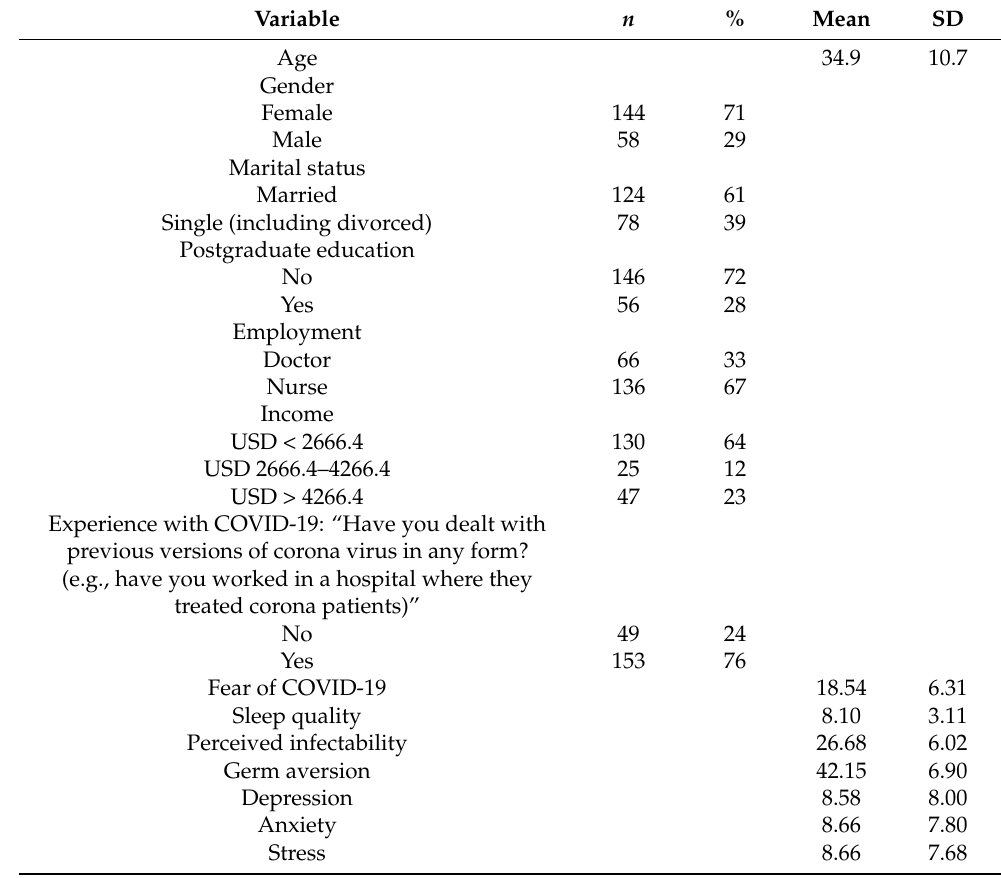
Table 1. Sociodemographic data and other characteristics of HCWs ( n = 202). SD, standard deviation.